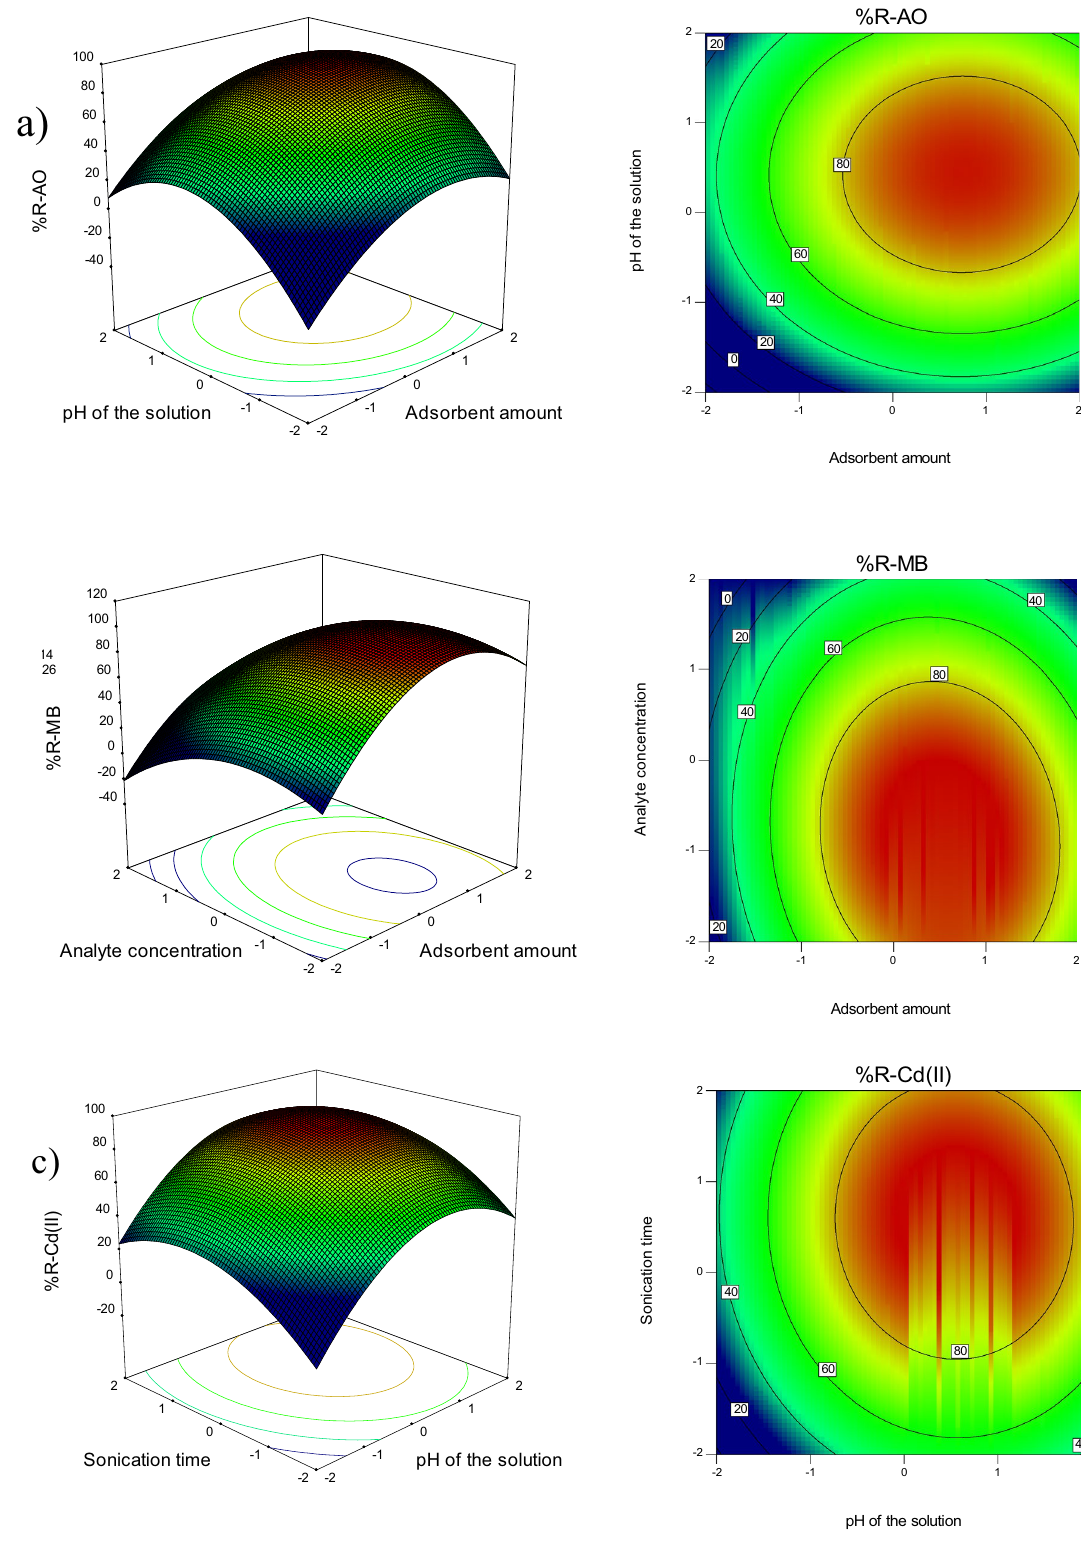
Figure 3. Three-dimensional plots and contour plots of the interaction effects between variables and removal (Removal conditions: adsorbent amount 0.25 g, pH = 6, sonication time 15 min, and concentration 15 mg L −1